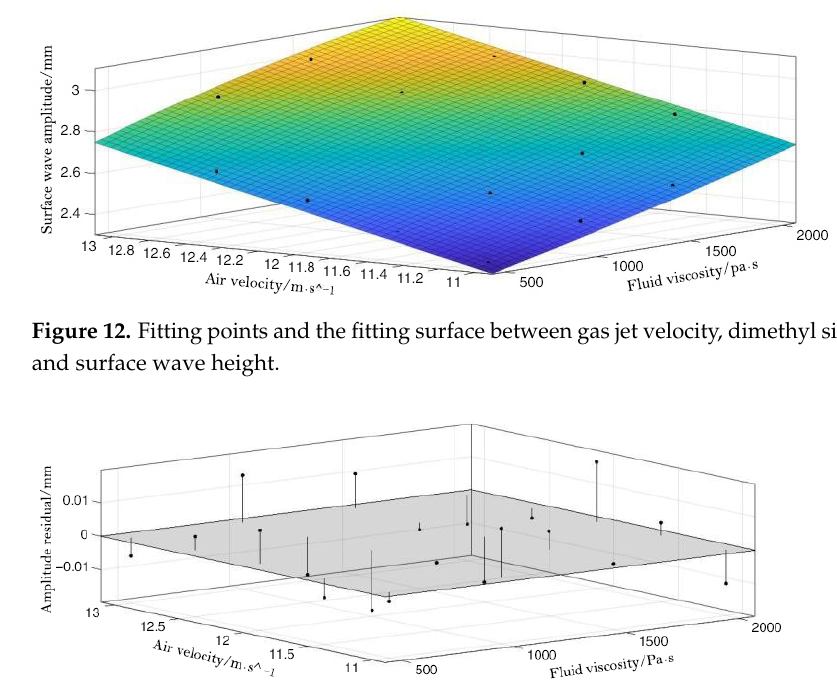
Figure 13. Calculated residuals for the relationship between gas jet velocity, dimethyl silicone oil viscosity and surface wave height.